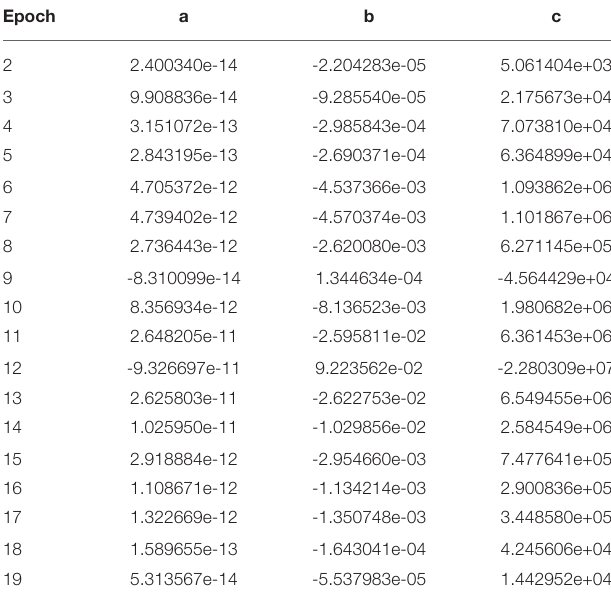
TABLE 3 | The mean gas production rate, ¯ q g [kg s − 1 ] as a function of ephemeris time (ET): ¯ q g ( ET ) = a · ET 2 + b · ET + c .